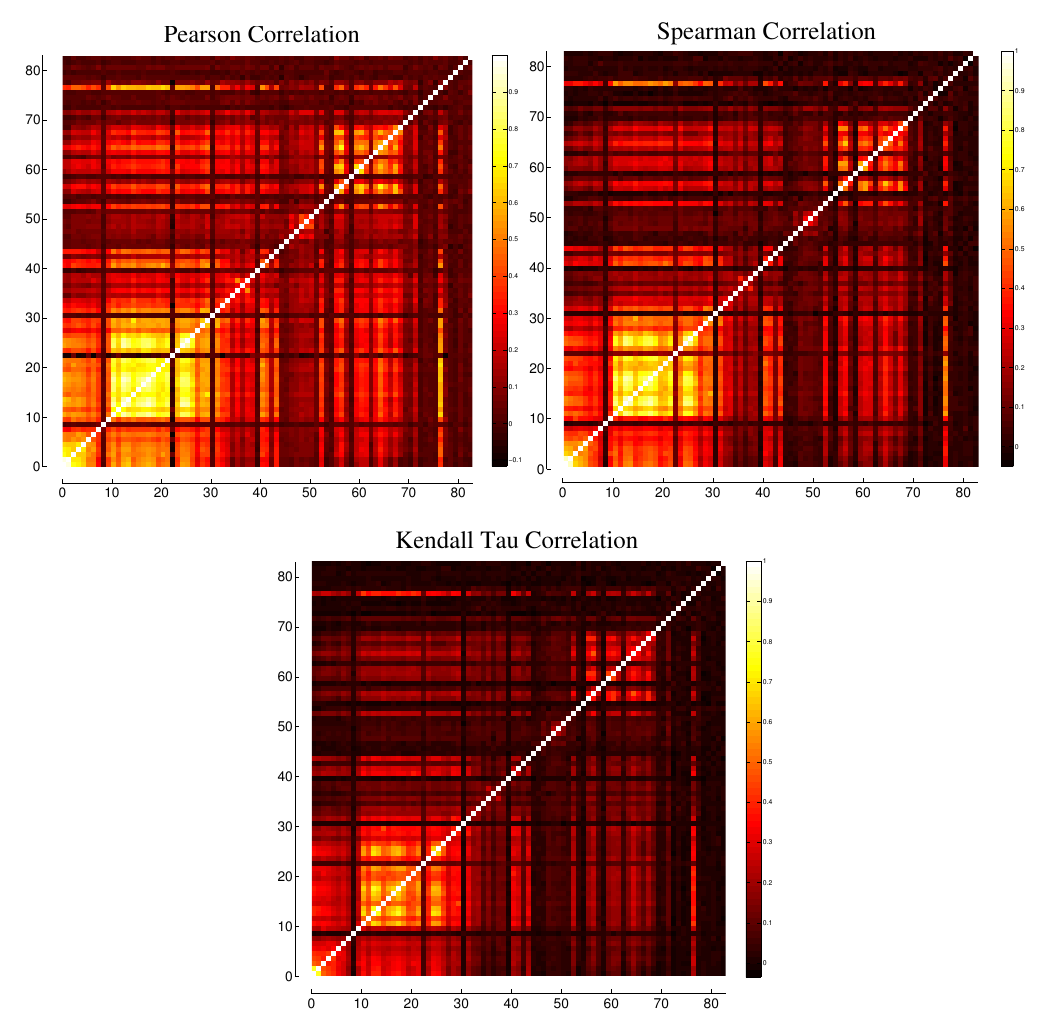
Figure 22. Correlation matrices using three different correlation measures: Pearson correlation, Spearman rank correlation, and Kendall tau rank correlation,